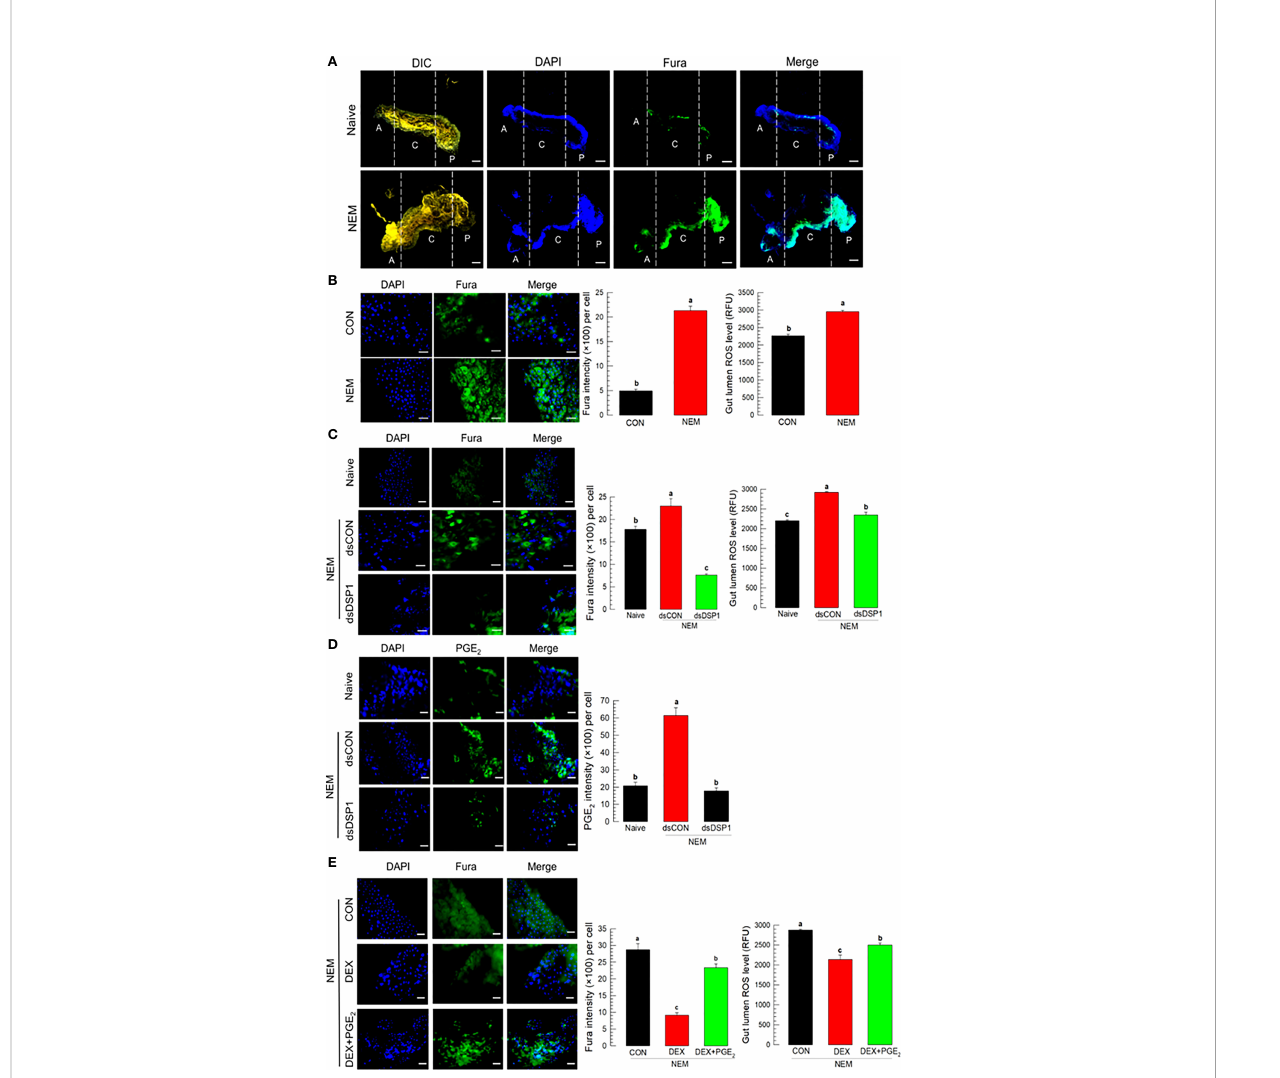
FIGURE 4 Ca 2+ signal after Se-DSP1 release via PGE 2 in response to gut infection by the entomopathogenic nematode ( ‘ NEM ’ ). Each L5 larva of S . exigua was fed with 80 IJs of S . feltiae . (A) Ca 2+ signals in the entire gut are separated into anterior ( ‘ A ’ ), central ( ‘ C ’ ), and posterior ( ‘ P ’ ). Nuclei were stained with DAPI. Fura-8AM was used to observe Ca 2+ . ‘ DIC ’ represents differential interference contrast. The scale bar indicates 100 µm. (B) Induction of Ca 2+ signal and subsequent up-regulation of ROS level in midgut in response to NEM treatment for 8 h. (C) Effect of RNAi speci fi c to Se-DSP1 expression on Ca 2+ signal in response to NEM treatment. At 24 h after dsRNA (1 µg/larva) injection, NEM was treated. After 8 h NEM treatment, Ca 2+ level and ROS amount were measured. (D) Induction of PGE 2 in the midgut epithelium. (E) Inhibitory effect of a speci fi c PLA 2 inhibitor (dexamethasone (DEX) on Ca 2+ signal and ROS level in midgut. NEM treatment was performed at 8 h after injection of DEX (10 µg/larva) or PGE 2 (1 µg/larva). Nuclei were stained with DAPI. PGE 2 was detected with a speci fi c antibody raised against rabbit. Fura- 8AM was used to observe Ca 2+ . Scale bars in B-E represent 10 µm. Different letters above standard error bars indicate signi fi cant difference among means at Type I error = 0.05 (LSD